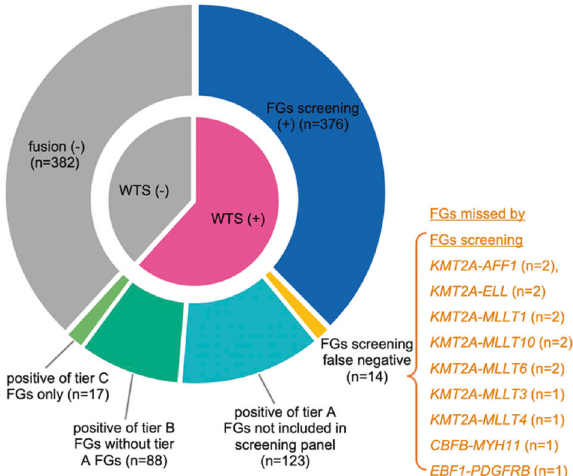
Fig. 7 Pie chart represented the comparison of results between whole transcriptome sequencing and fusion genes screening. WTS whole transcriptome sequencing, FG fusion